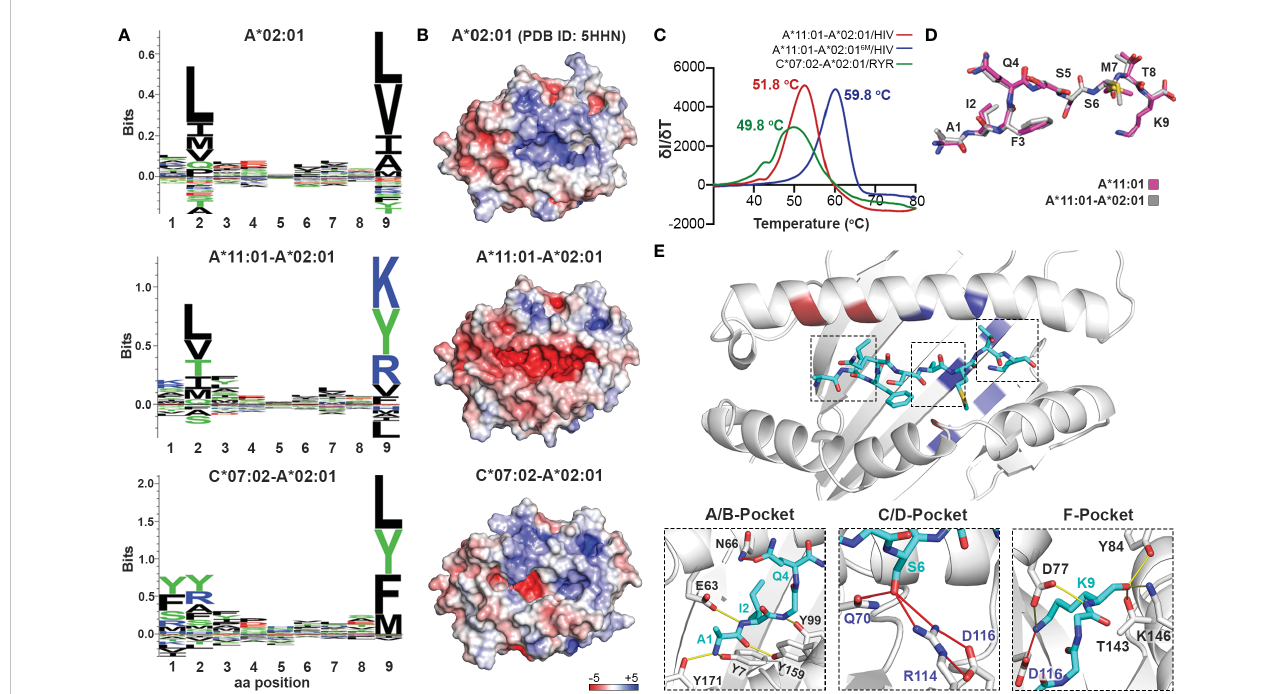
FIGURE 3 Production of chimeric HLA-A*02:01 peptide complexes with altered B- or F-pocket speci fi cities according to A*11:01 or C*07:02 structural templates. (A) Sequence logos of HLA- A*02:01, A*11:01-A*02:01, and C*07:02-A*02:01 molecules rendered using an in-house protocol and visualized in Seq2Logo from the NetMHCpan4.0 (40). (B) Electrostatic surface potential analysis for HLA-A*02:01 (PDB ID: 5HHN), A*11:01-A*02:01, and C*07:02- A*02:01 calculated using the APBS solver in PyMOL. In all panels, the electrostatic surface potential is shown as a range between +5 kT/e (in blue) to -5 kT/e (in red) representing positive and negative charges, respectively. k B, Boltzmann constant; T, temperature; e, unit charge. (C) Thermal stabilities of HLA-A*11:01-A*02:01/HIV-1 RT (red), A*11:01-A*02:01 6M /HIV-1 RT (blue), and C*07:02-A*02:01/RYR (green). Data are mean ± SD obtained for n = 3 technical replicates. (D) Overlay of the HIV-1 RT peptide bound to the chimeric HLA-A*11:01-A*02:01 (grey) and wild-type A*11:01 (magenta) molecules. (E) Crystal structure of the HLA-A*11:01-A*02:01/HIV-1 RT complex. Substitutions of the HLA-A*11:01-A*02:01 (red and blue) and A*11:01-A*02:01 6M (blue) chimeras are highlighted. Hydrogen bonds and salt bridges between the peptide and the base or groove allele residues are represented by yellow or red lines, respectively. Peptide, A*02:01-speci fi c, and A*11:01-speci fi c residues are labeled in cyan, black, and blue font,